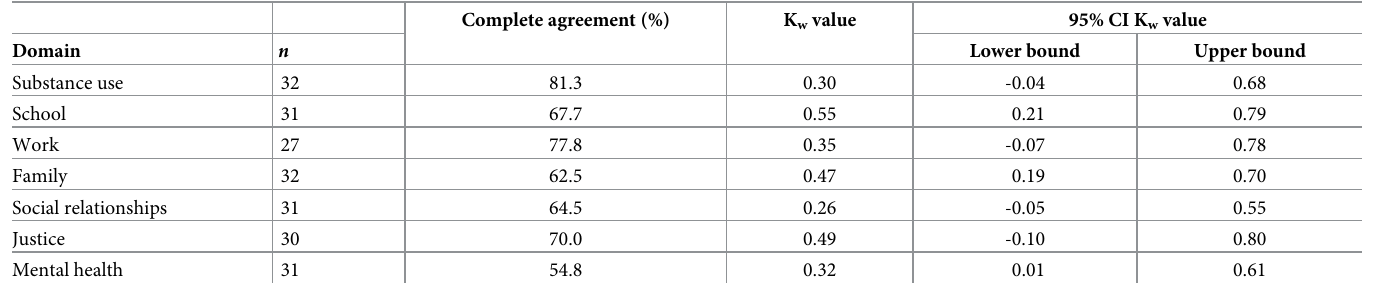
Table 4. Test-retest reliability of ASC T-ASI domains in percentage of complete agreement and K w coefficients a